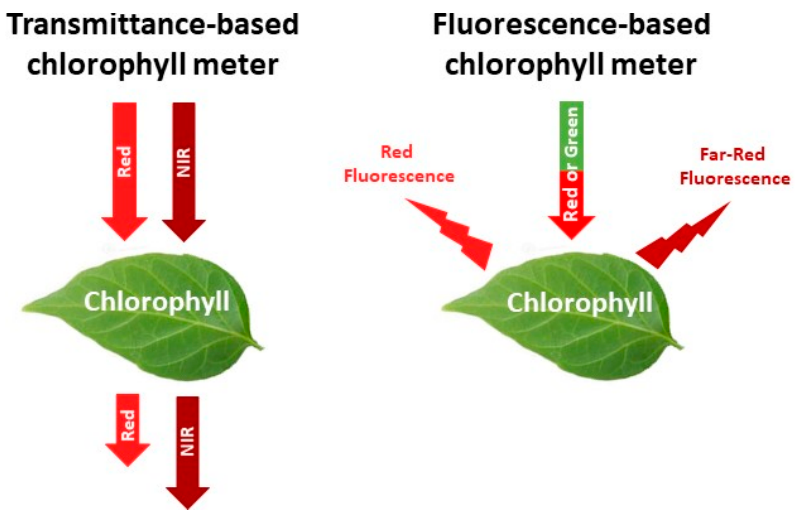
Figure 1. Functioning of two different types of chlorophyll meters used to estimate leaf chlorophyll content.